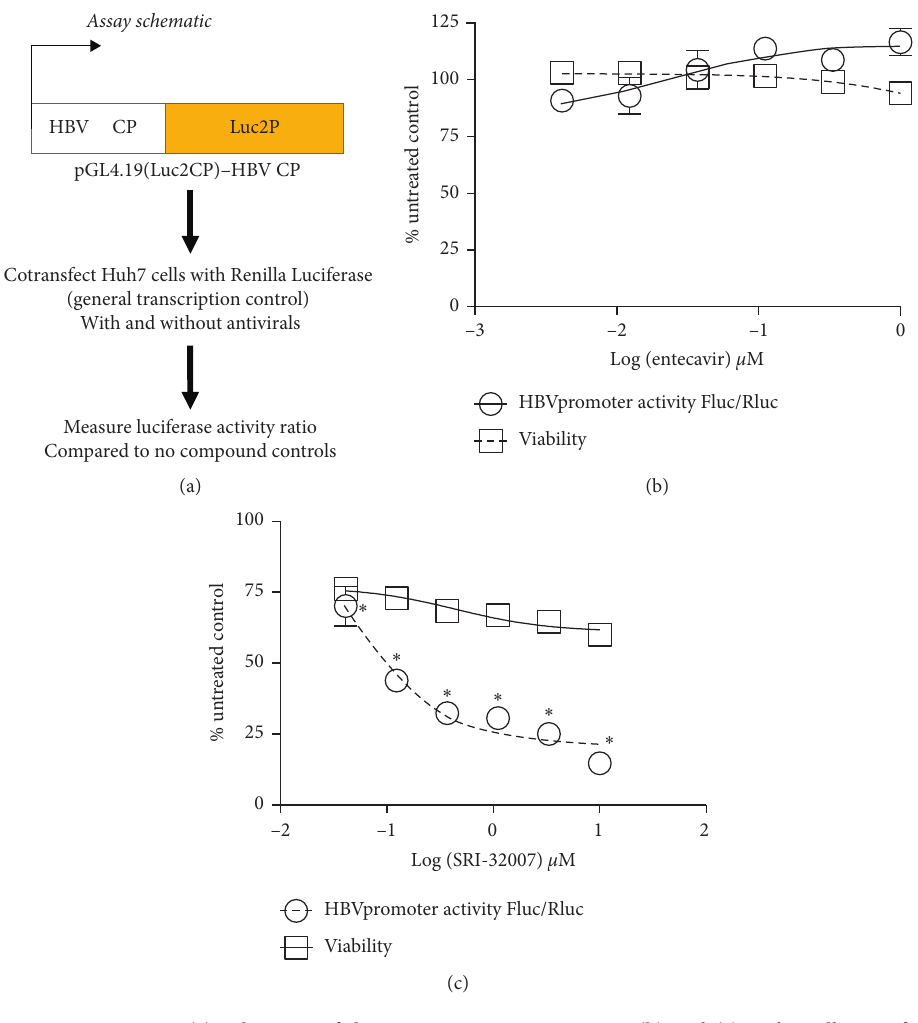
Figure 4: HBV core promoter assay. (a) Schematic of the HBV core promoter assay: (b) and (c) Huh7 cells transfected with plasmid containing HBV core promoter fused to firefly luciferase along with another plasmid encoding renilla luciferase under the control of SV40 promoter were treated with increasing concentrations of SRI-32007 or entecavir, followed by measurement of luciferase activity post- treatment. Ratio of firefly luciferase to the renilla luciferase in Huh7 cells treated with either entecavir (b) or SRI-32007 (c) normalized to the untreated controls (mean ± standard deviation) are shown in the figure. This experiment was repeated twice to confirm the reproducible inhibition of HBV core promoter by SRI-32007. A representative graph from one experiment is shown in the figure. Stars ( ∗ ) show statistical significance p < 0 . 05 compared to the untreated control (Dunnett’s multiple comparison test, one-way ANOVA, GraphPad Prism